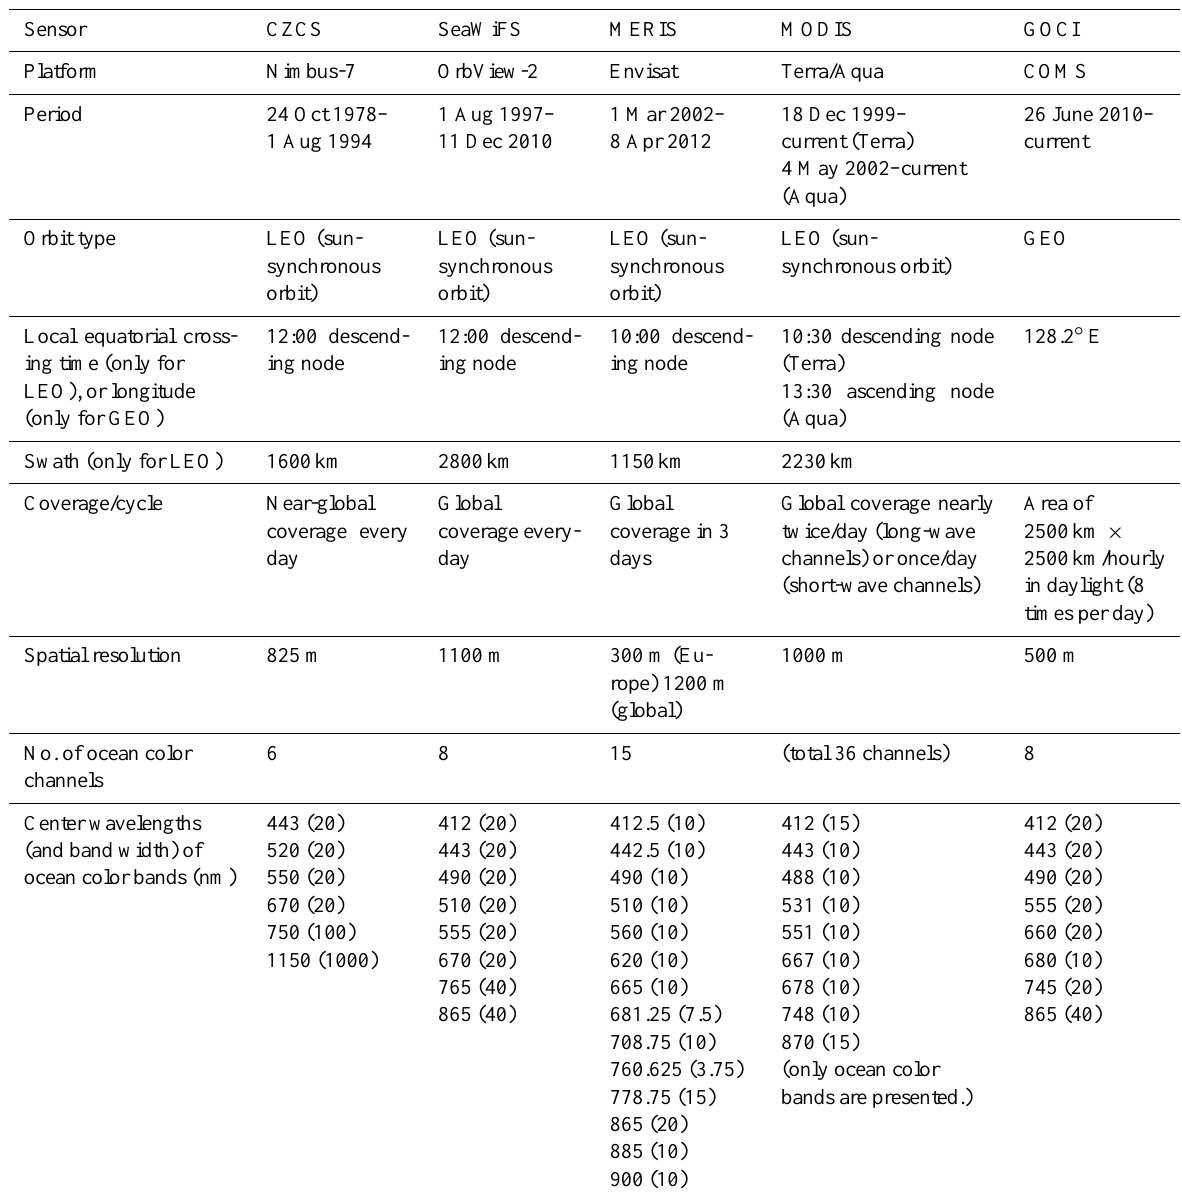
Table 1. The specification of ocean color sensors.